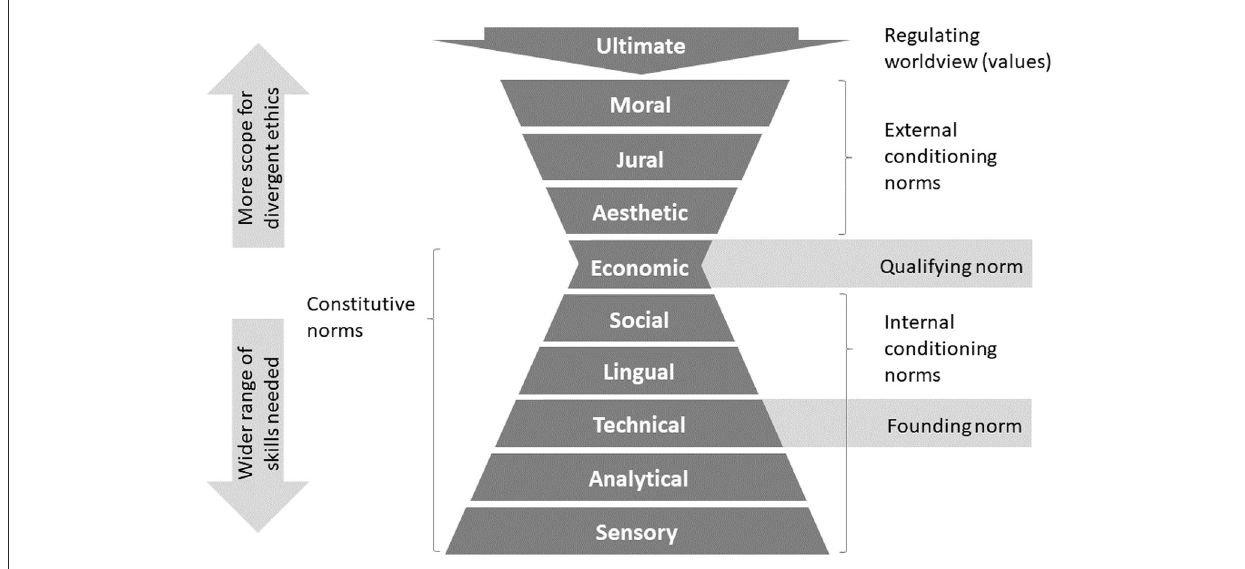
FIGURE1 The normative practices approach to agriculture. Farming strategies are shaped by values regulated in the ultimate aspect. Once a strategy considers norms beyond (here, above) the economic, it may be termed enlightened agriculture .